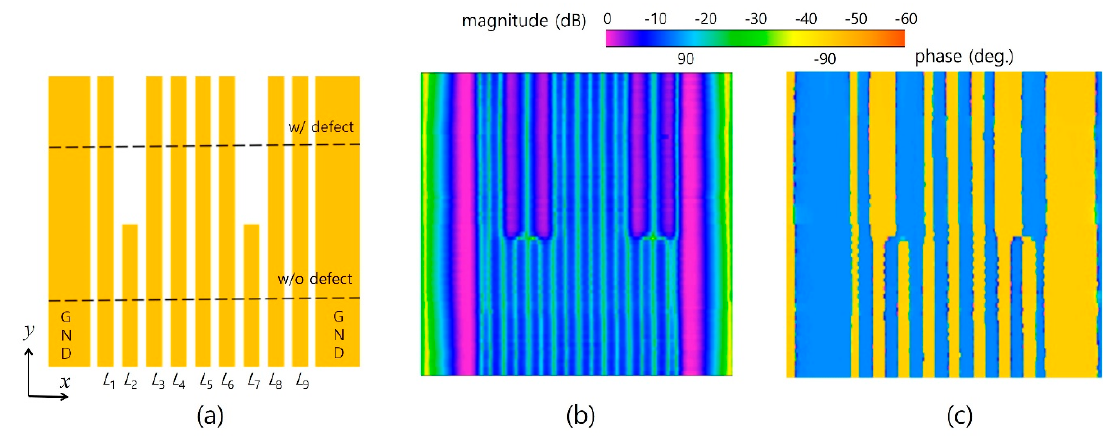
Figure 6. Horizontal electric field distribution over nine ( n = 9) CPW lines ( L/g/G = 100/60/52 μ m) with artifacts: ( a ) layout, ( b ) magnitude image, and ( c ) phase image.